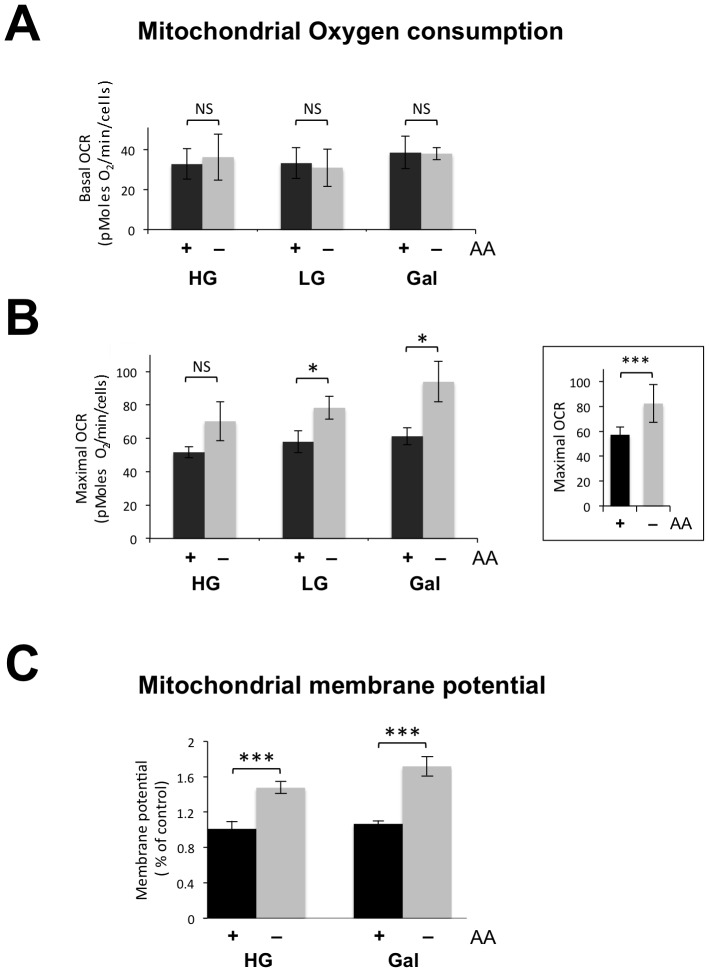
Amino acid starvation increases mitochondrial respiration and membrane potential.HEK cells were cultured in 25(HG), 5 mM glucose (LG), or 5 mM galactose (Gal), with (+) or without (−) the 15 amino acids (AA) present in the standard formulation of DMEM (Table S1). The same notation is used in subsequent figures. Mitochondrial oxygen consumption rate (OCR) was measured using a flux analyser before (basal) (A) and after the addition of FCCP (maximal) (B), having subtracted the non-mitochondrial (rotenone-insensitive) OCR. Inset shows maximal OCR of HEK cells grown in the presence or absence of amino acids combining the three sets of values for the different sugar concentrations shown in panel B. (C) Mitochondrial membrane potential was assessed by a quantitative flow cytometry analysis of TMRE fluorescence. The fluorescence values were normalized to those of HEK cells grown in HG with amino acids. The data represent the mean ± standard error of the mean (s.e.m) of 3 independent experiments, each one performed in duplicate. Statistical analysis was performed using the unpaired two-tailed Student’s t-test. Asterisks indicate the level of statistical significance (P<0.05 *, P<0.01 **, and P<0.001 ***); NS, not significant (p>0.05).